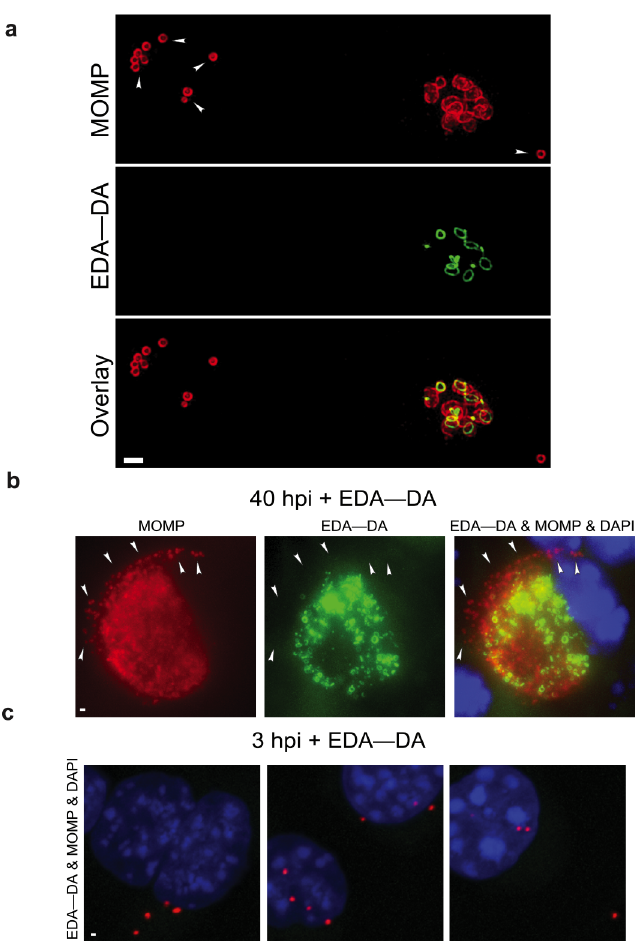
Fig 3. Chlamydial EBs do not retain PG labeling. (a) SIM of EDA — DA labeled C . trachomatis inclusions at 22 hpi. Arrowheads indicate locations of EBs. Tissue culture cells were infected with C . trachomatis and placed on a rocker for 2 hours, ensuring asynchronous infection of the cell monolayer. Bacteria were then incubated with 4 mM EDA-DA for 22 hours. (b) Confocal maximum intensity projections of a mature, Chlamydia inclusion (40 hpi) in which bacteria were grown in the presence of 4 mM EDA — DA for the entire developmental cycle. The arrowheads point to EBs (distinguished by their MOMP labeling and smaller size). (c) Confocal maximum intensity projections of Chlamydia -infected cells 4 hpi. EBs used for infection were harvested from cells that had been incubated with EDA — DA for 18 hours. Exogenous EDA — DA (4 mM) was present throughout the EB harvest as well as the subsequent reinfection. MOMP and PG labeling is the same as in Fig 2. Images are all representative of at least three separate experiments. Scale bar = 1 μ